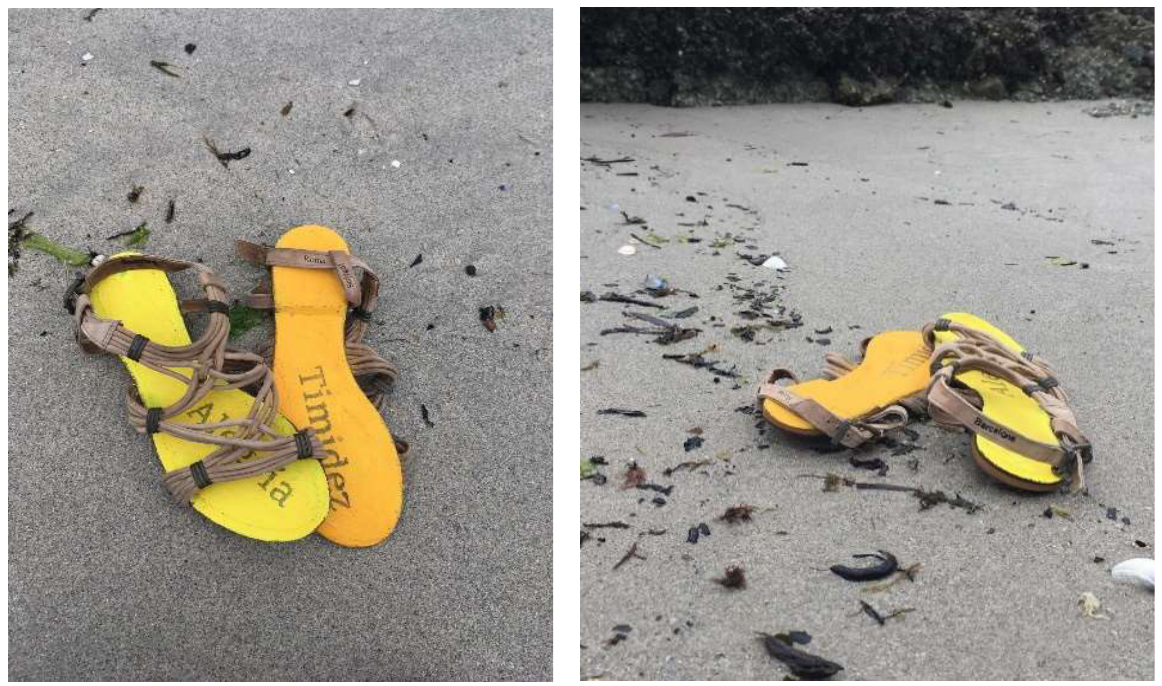
Figure 1. Intertwined. Photography